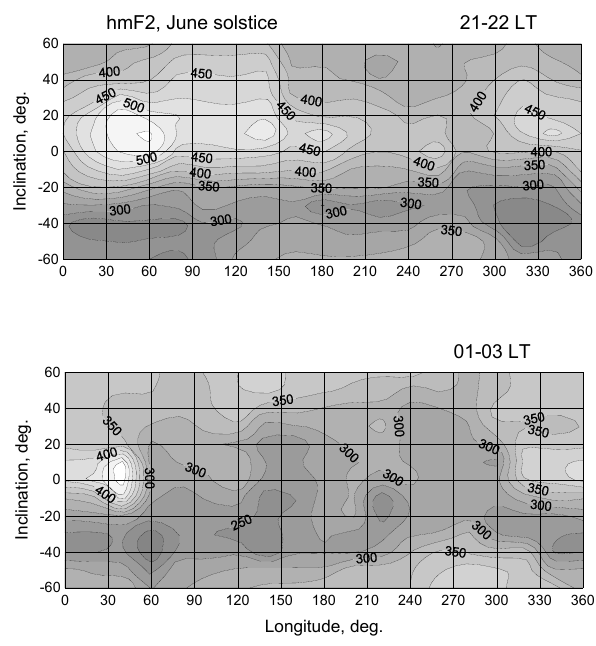
Fig. 6. The same as in Fig. 5 but for hm F2 and two LT intervals. Fig. 7 to the manuscript by G.F. Deminova "Maps of foF2, hmF2, ..."